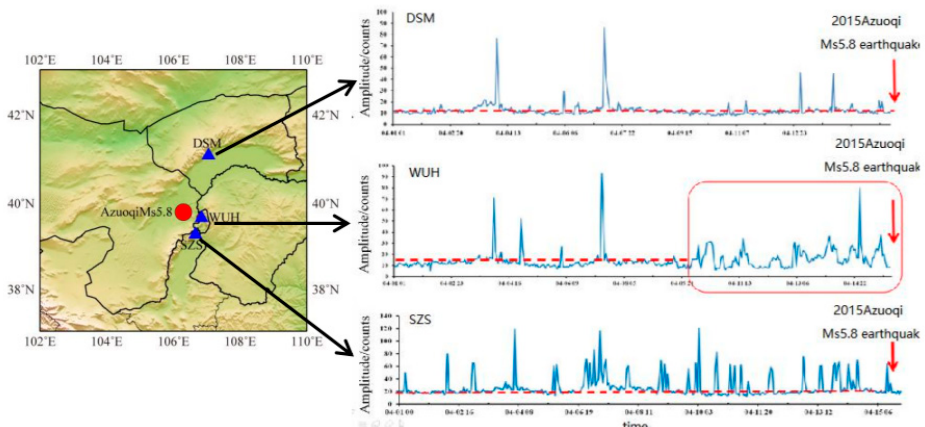
Figure 6. Tracking results of low-frequency envelope maximum values of DSM, SZS and WUH around the 2015 Azuoqi M5.8 earthquake in Inner Mongolia.